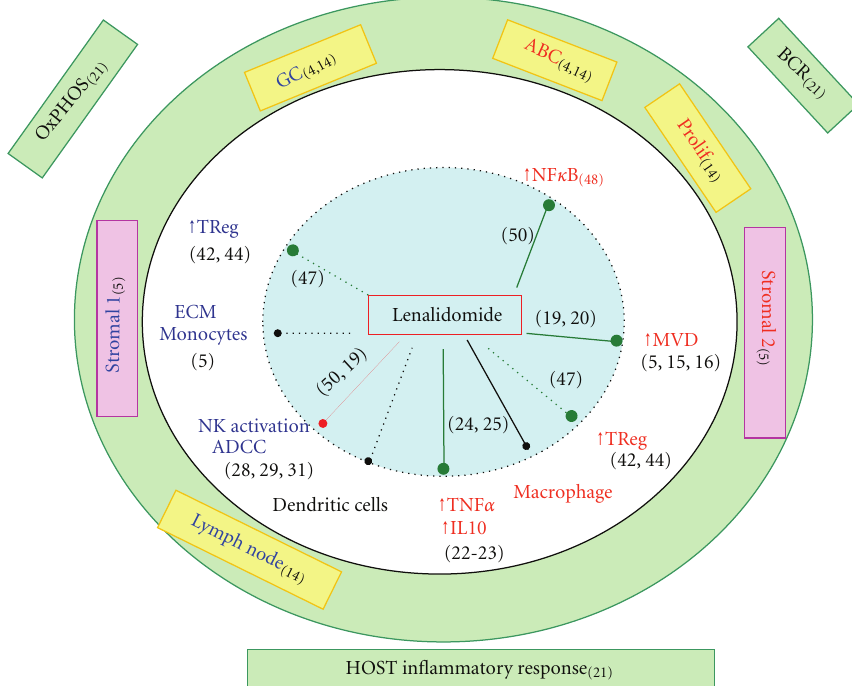
Figure 1: Biological e ff ects of lenalidomide. Colored insets show the main transcriptomic signatures described in DLBCL. Just outside the circle are the signatures with prognostic impact. Inside the circle are indicated the factors studied in DLBCL, either with bad (red characters), good (blue), or undetermined (black) prognostic impact. Arrows indicate a negative (green), positive (red), or undetermined (black) regulation of lenalidomide on those factors in DLBCL. ECM: extracellular matrix components. MVD: microvascular